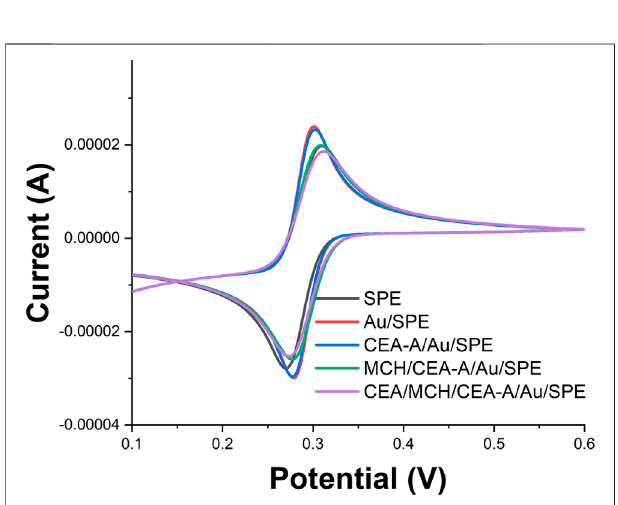
FIGURE5| CV pro fi lesofaptamersenorduringthefabricationrecorded in 5 mM [Fe(CN) 6 ] 3 − /4 −